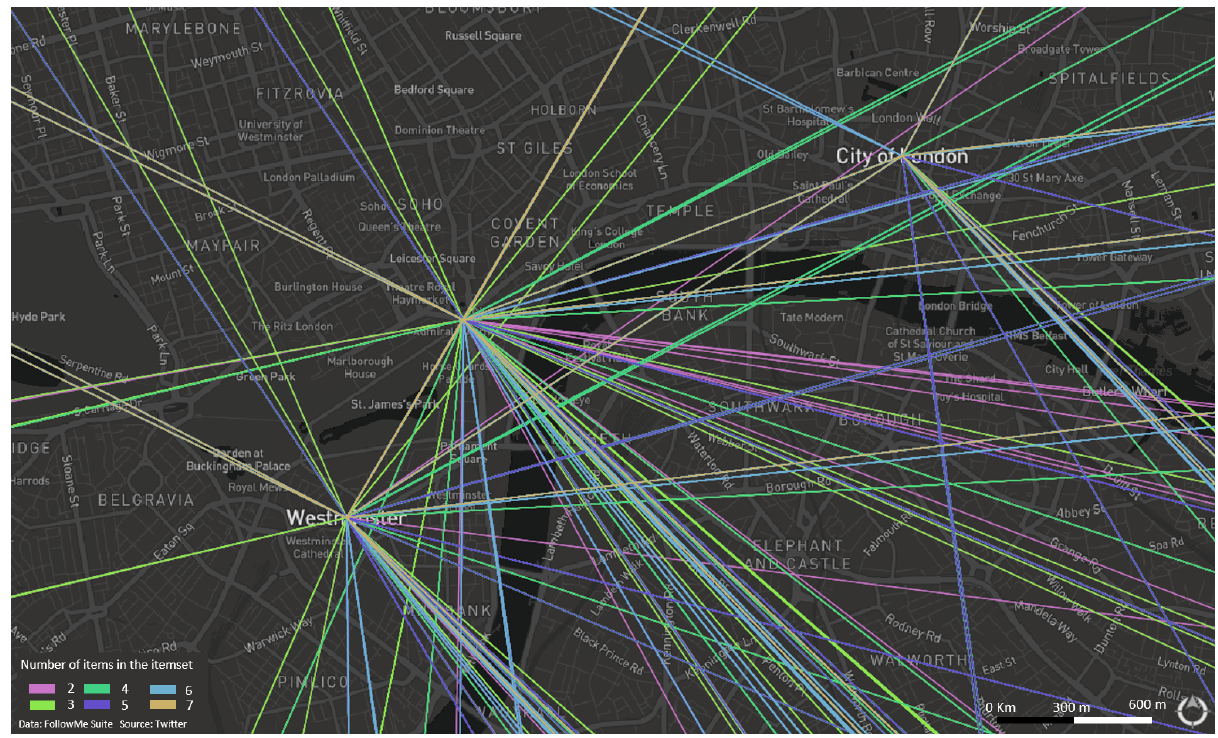
Figure 16. Topographic representation for discovered itemsets from the large data set by applying Interpretation 1, focused on London (UK)